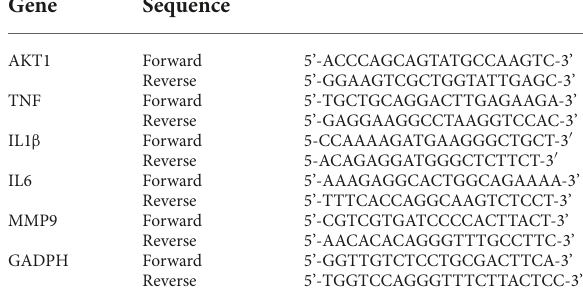
TABLE 1 List of primers used for the